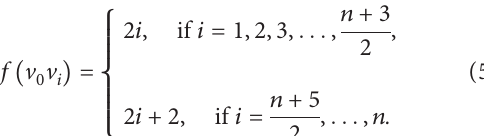
Figure 2: The path graph P